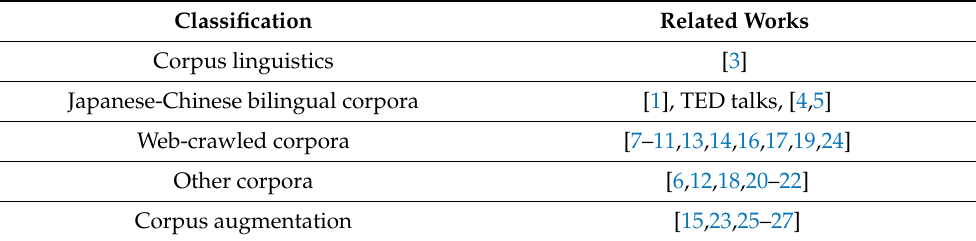
Table 1. Summary of related